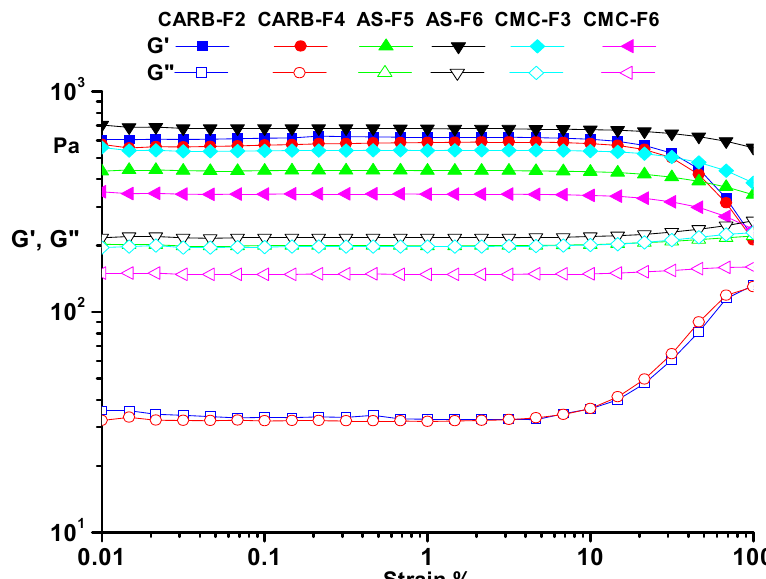
Figure 2. Amplitude sweep for simple gels (CARB-F2, AS-F5, and CMC-F3) and gels with CD-NHF (CARB-F4, AS-F6, and CMC-F6). G’: storage modulus; G”: loss modulus.